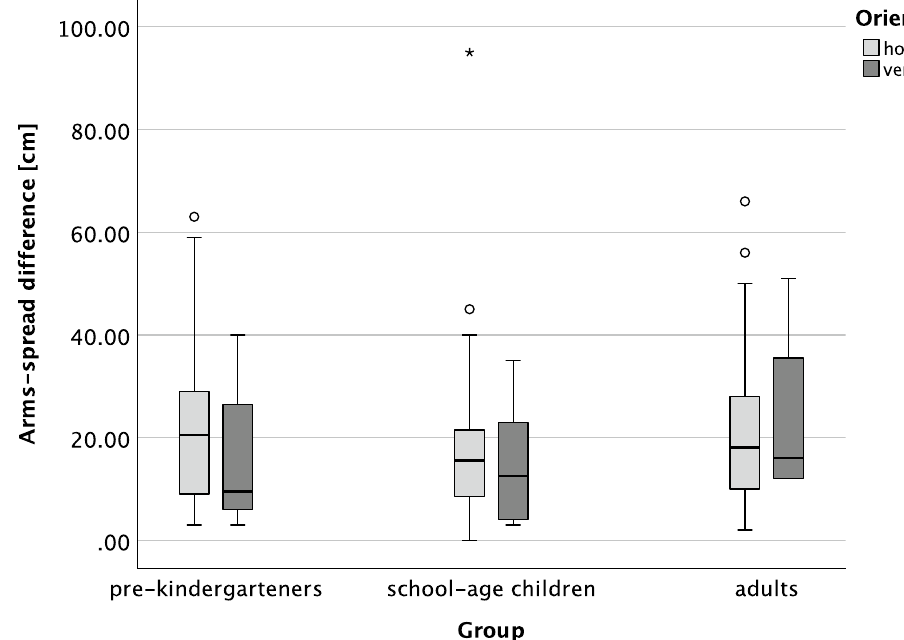
Figure 4. The box plot of arm spread differences in expression of relative durations, i.e., the difference between the expression of shorter and longer durations in centimeters, grouped by age groups (pre-kindergarteners, school-age children, and adults) and arm orientations. The lower and upper edges of gray rectangles represent the boundaries of the first and third quartiles of the data, respectively. The horizontal lines inside the boxes are the medians, and the whiskers represent the minima and maxima, excluding the outliers. Open circles and the asterisk represent